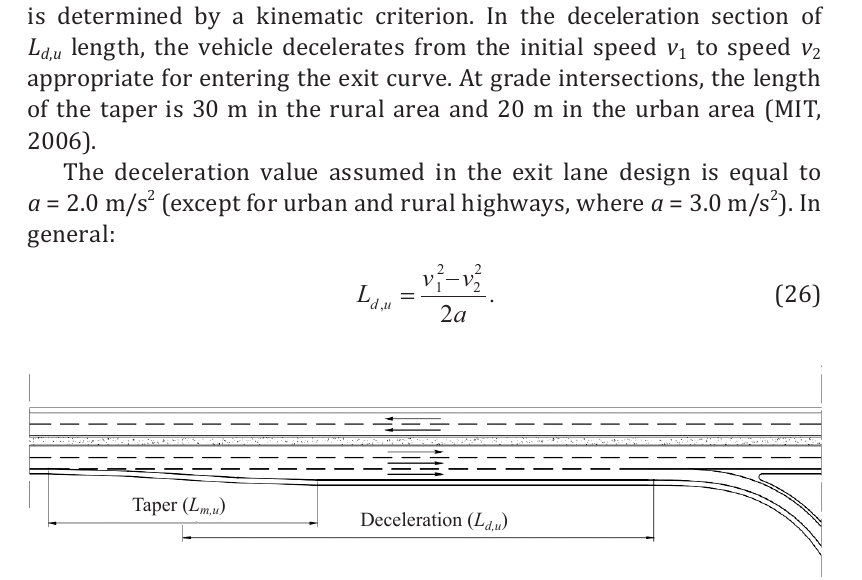
Figure 1. Exit lane (parallel type)